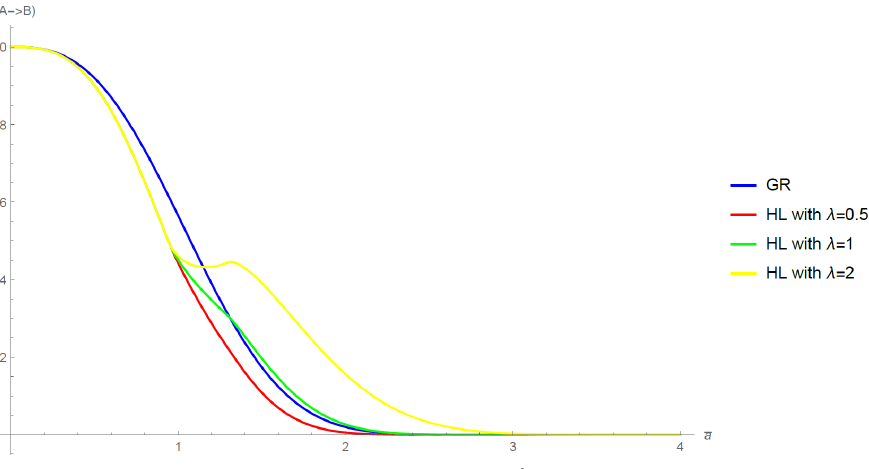
= − 1, V = − 10, ¯ α = ¯ α = 5 = 1, with V B 2 3 A ¯ h